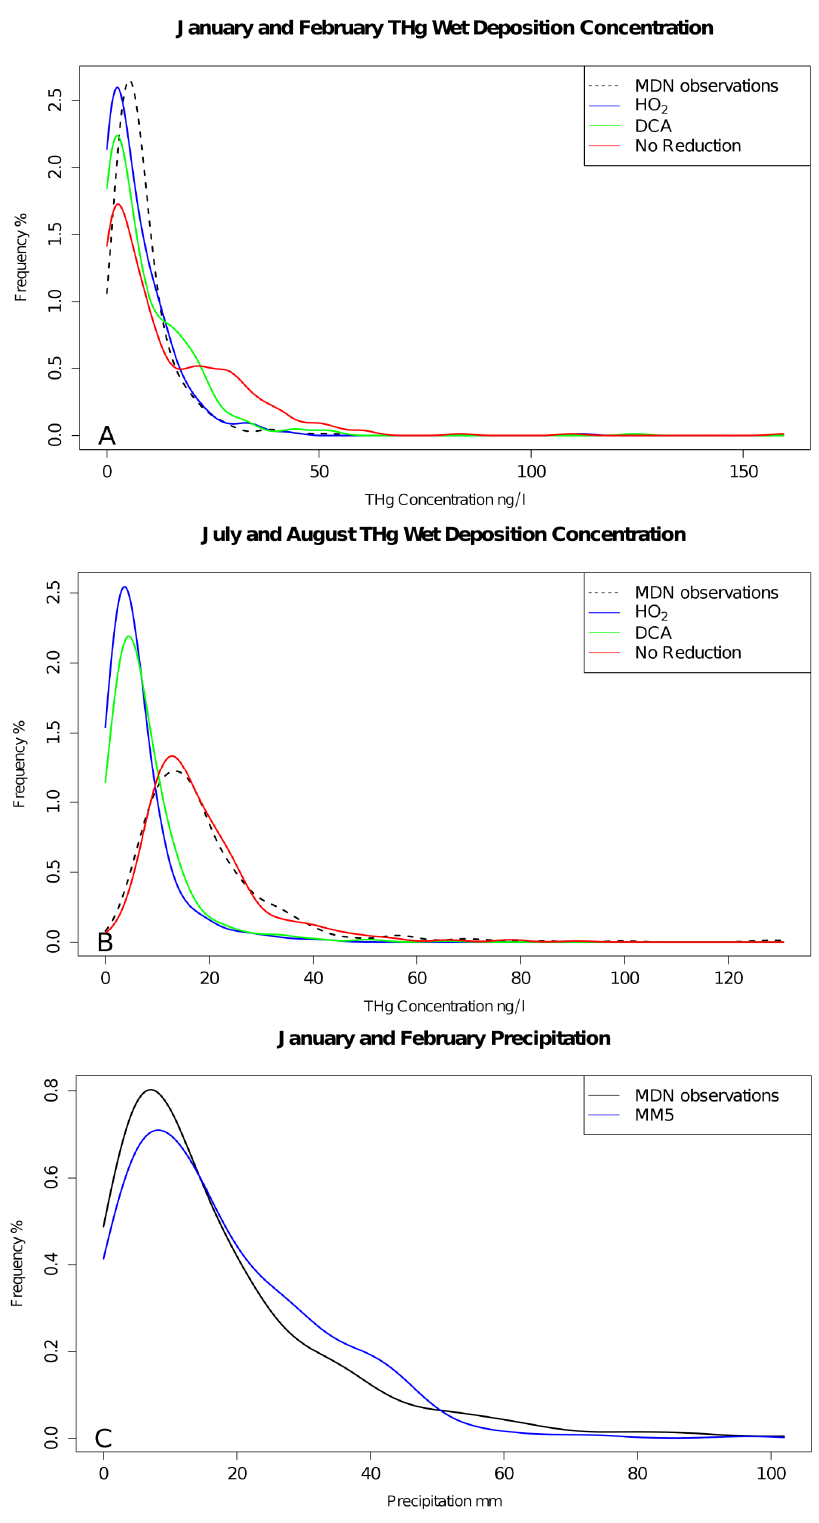
Figure 4. Distribution of the weekly observed (black dashed line), HO (green) and NAR (red) cases for January and February simulations ( A ), July and August simulations ( B ), and for weekly observed (black) and modeled (blue) precipitation for January and February ( C ), and July and August ( D